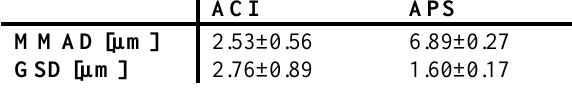
Table 1 . APSD parameters measured by two different methods.